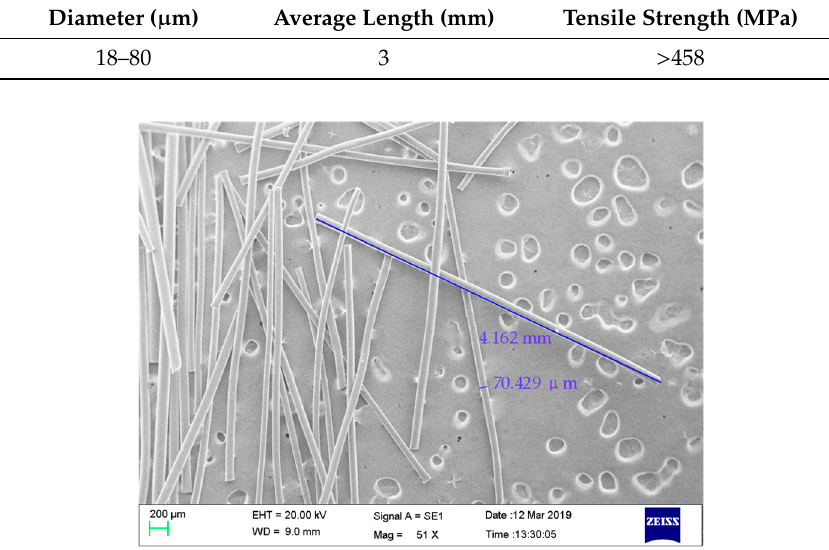
Figure 1. Polypropylene fiber used in this study.